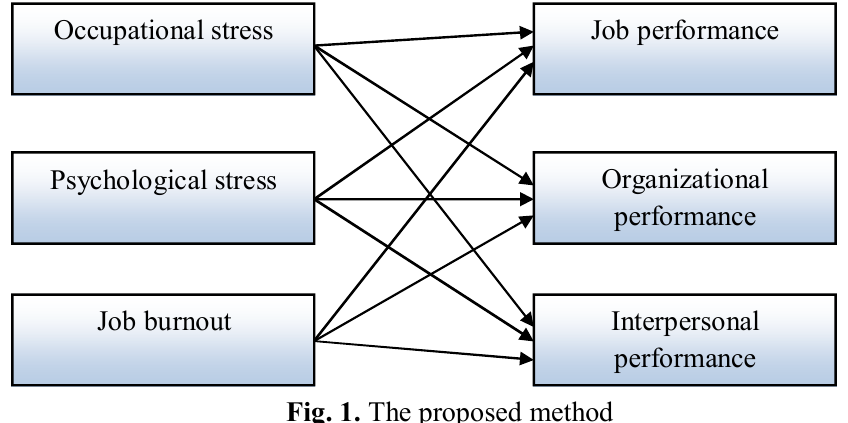
Fig. 1. The proposed